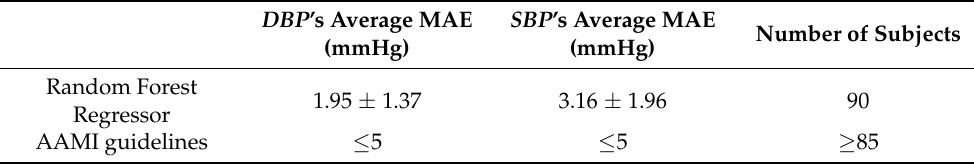
Table 3. Comparison of the results related to the MIMIC III database and the AAMI